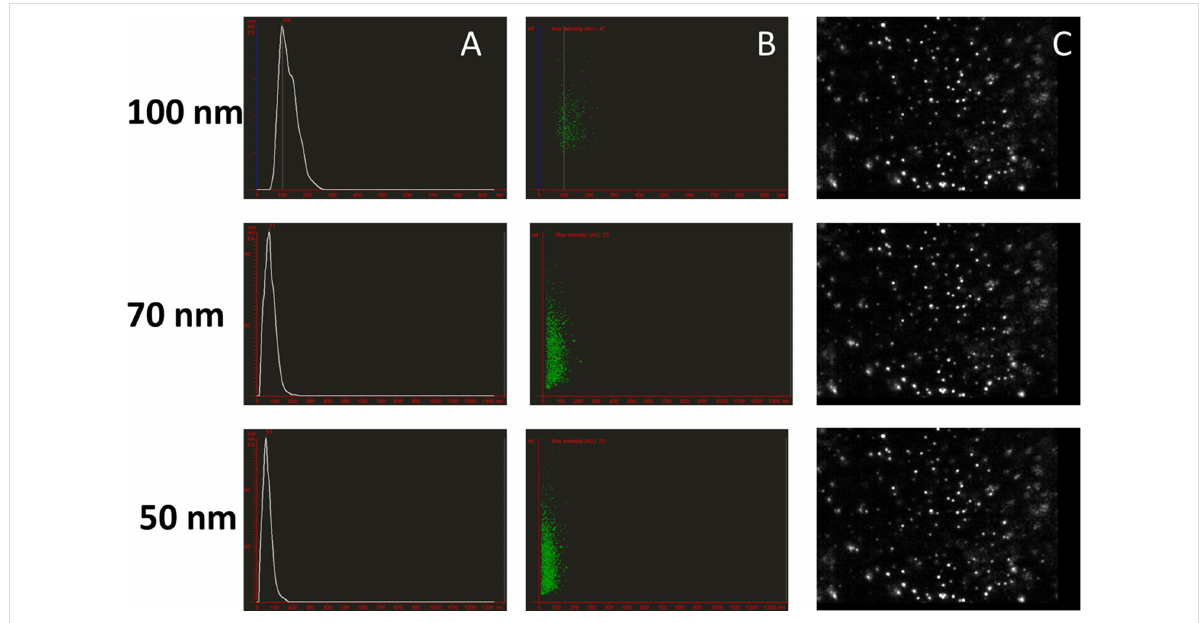
Figure 2: NTA measurement of Au-CPMV at 25 °C recorded from three consecutive runs (60 s) for each sample. (A) particle size (concentration par- ticles/mL as a function of the size); (B) representative NTA scattering distributions of each population (size as a function of intensity) showing compact clustering and indicating highly monodisperse particles with no aggregation, each dot represents a single particle; (C) representative NTA video frame. Data was recorded from six independent